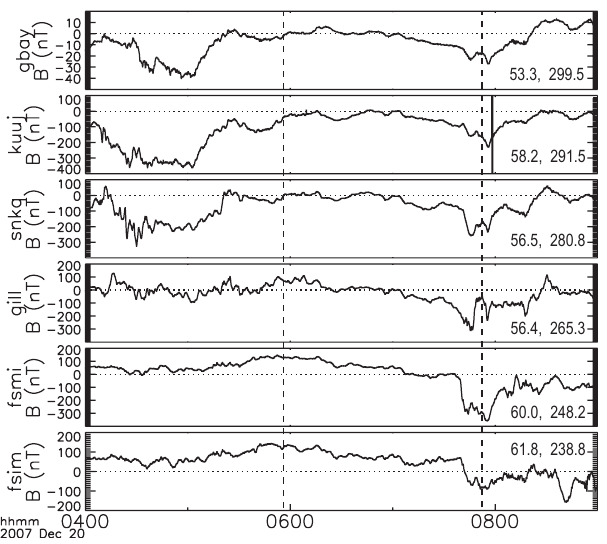
Fig. 2. Ground-based magnetic field observations during 04:00– 09:00UT. From top to bottom: B x component (northward) with daily median value subtracted measured by THEMIS GBO from east to west along the THEMIS ground track on the Northern Hemi- sphere. Vertical dashed bars bound the interval of flapping, ob- served by THEMIS probes. Geographic coordinates of the stations are specified.